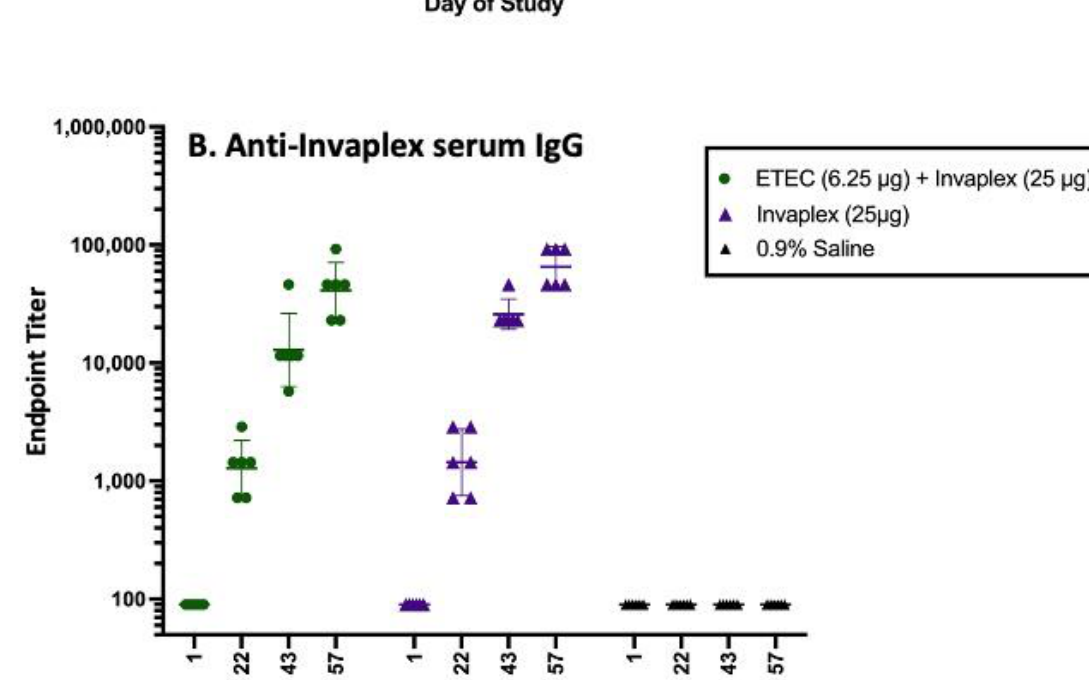
Figure 2. Immune response to Shigella and ETEC CS3 antigens in a combined vaccine as shown in Figure 3. CS6 and CFA/I in combination with dmLT or Invaplex had significantly higher anti-CS3 antibody titers compared with titers after immunization with CS3, CS6, and CFA/I alone (Panel A). The immune response to CS6 was similarly enhanced, but the immune response to CFA/I was unaffected. Serum IgG titers directed in Invaplex (Panel B) were comparable in guinea pigs immunized with CS3, CS6, and CFA/I delivered alone or in combination with Invaplex, indicating that the ETEC antigens did not interfere with the Shigella antigen-specific immune responses. For these unpublished data (R. Kaminski), Guinea pigs (Hartley strain; six pigs/grp) were immunized intradermally on study days 1, 22, and 43 with either 6.25 µg of CFA/I, CS3, and CS6 delivered with and without dmLT (500 ng) or Invaplex (25 µg). Blood collected on days 1, 22, 43, and 57 were assayed by ELISA for serum IgG titers directed to CS3 ( A ) and Invaplex ( B ). Data represents the geometric mean titer and 95% confidence interval.